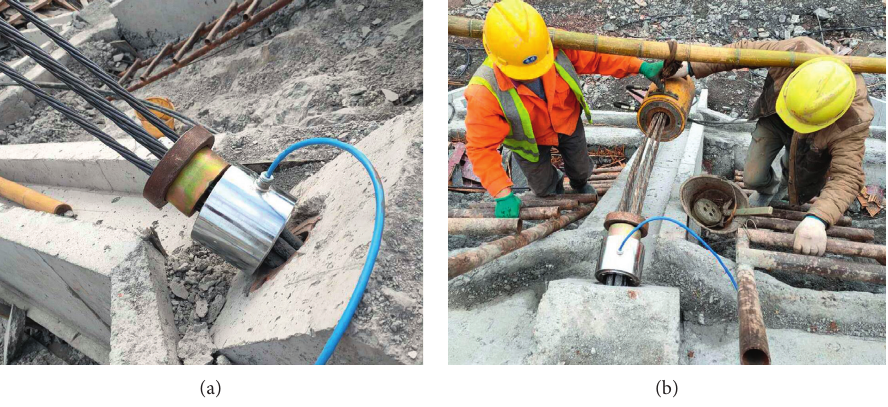
Figure 3: Installation of the anchor cable meter.